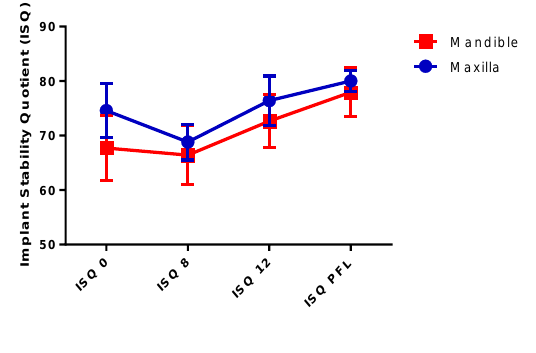
Figure 3: Line graph showing the difference in implant stability in relation to DI diameter